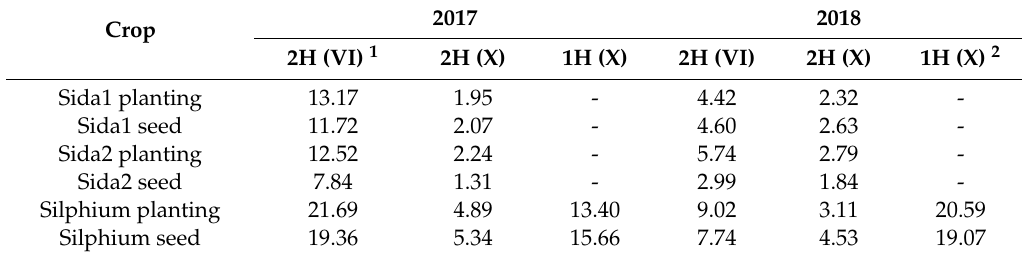
Table 1. Mean of dry matter yield of Sida and Silphium (t ha − 1 ) harvested on di ff erent dates.